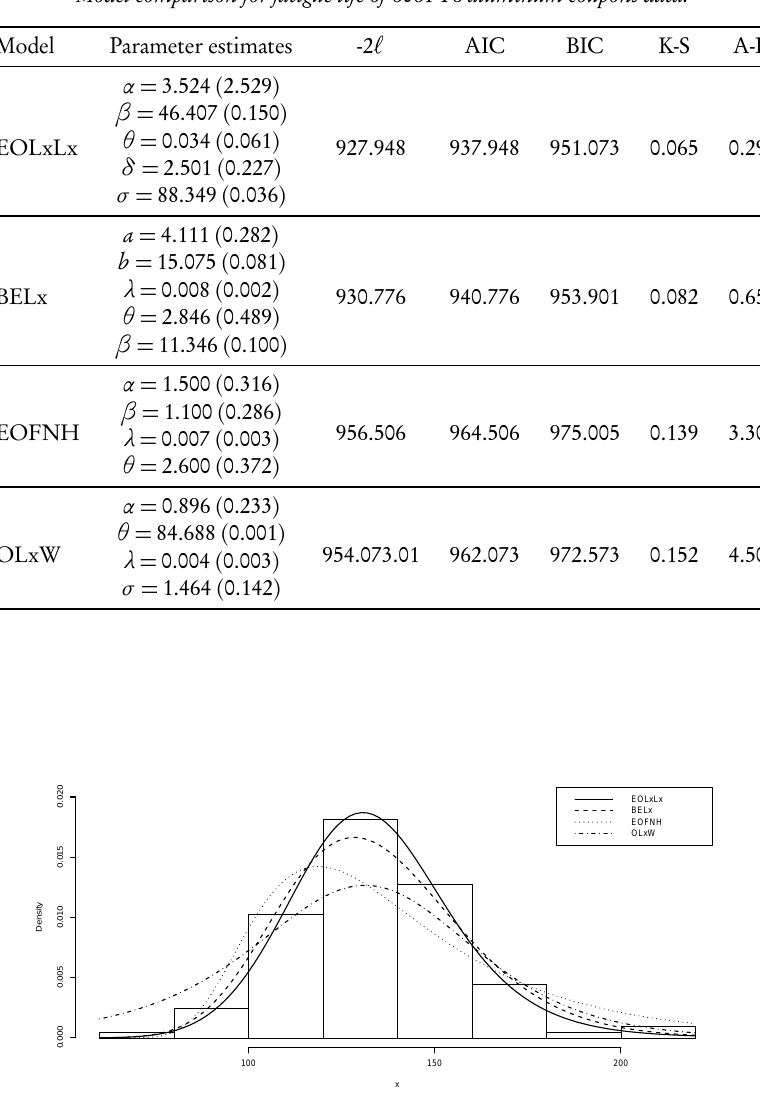
Figure 8 – The estimated densities of EOLxPL, KwTLL, OLxLL and OP